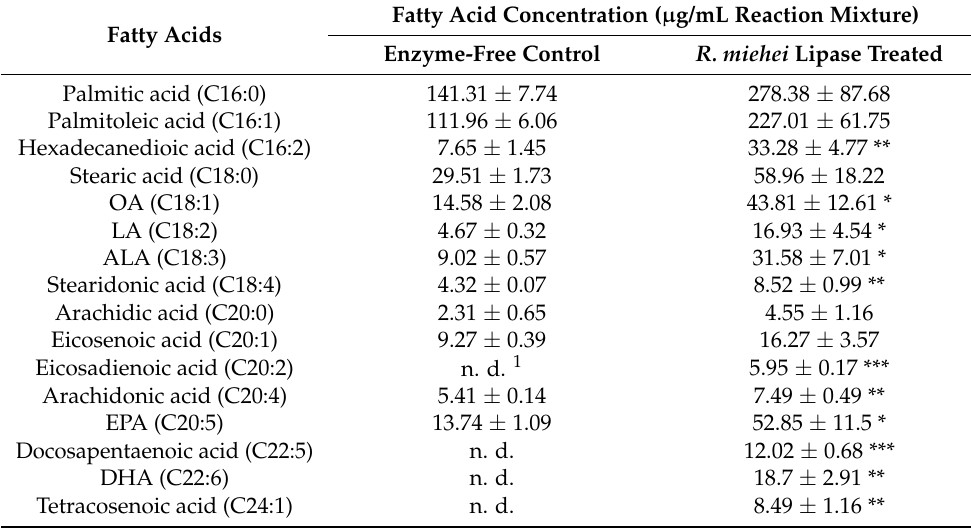
Table 2. Concentrations of free fatty acids detected in menhaden fish-oil-containing mixtures by GC-MS before (enzyme-free control) and after treatment with R. miehei lipase (40 ◦ C, 24 h). Fatty Acid Concentration ( µ g/mL Reaction Mixture) Fatty Acids Enzyme-Free Control R. miehei Lipase